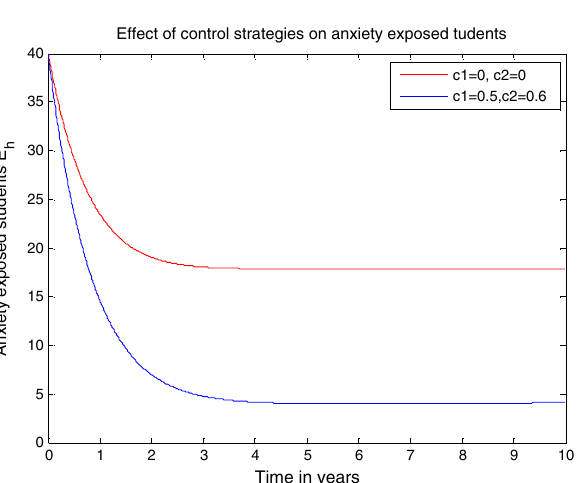
Figure 12. Effect of protection and treatment strategies on the number of anxiety exposed students ( E h ).